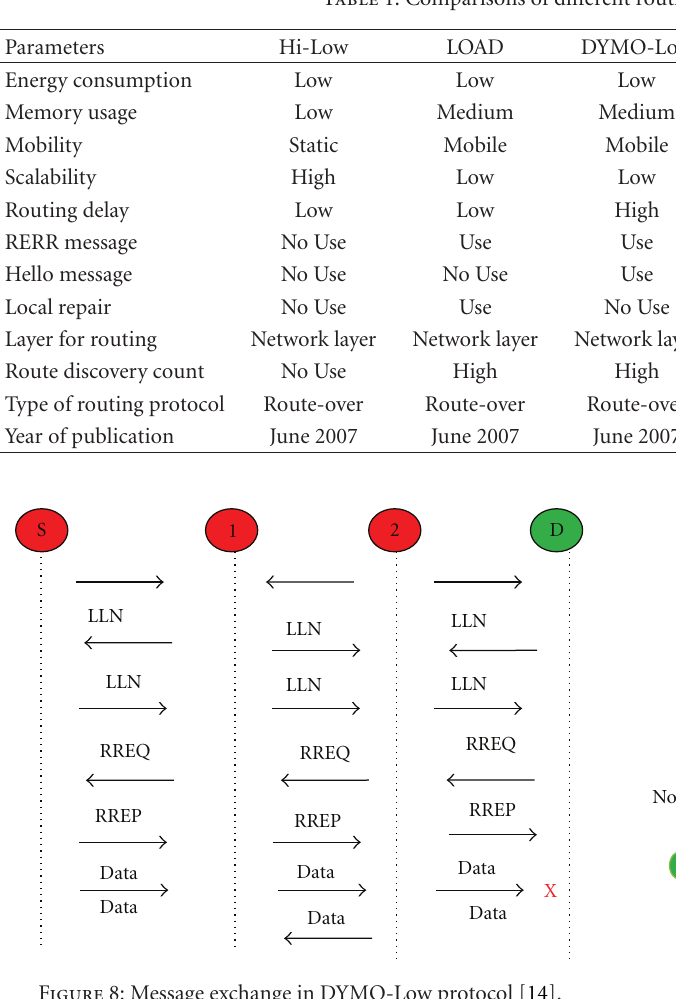
Figure 8: Message exchange in DYMO-Low protocol [14].